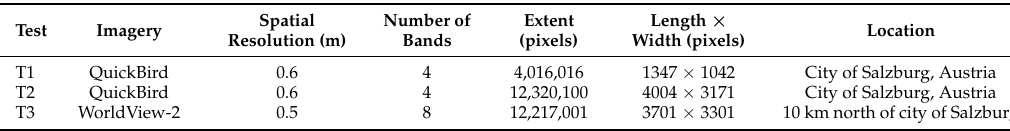
Table 1. Summary and characteristics of the three test